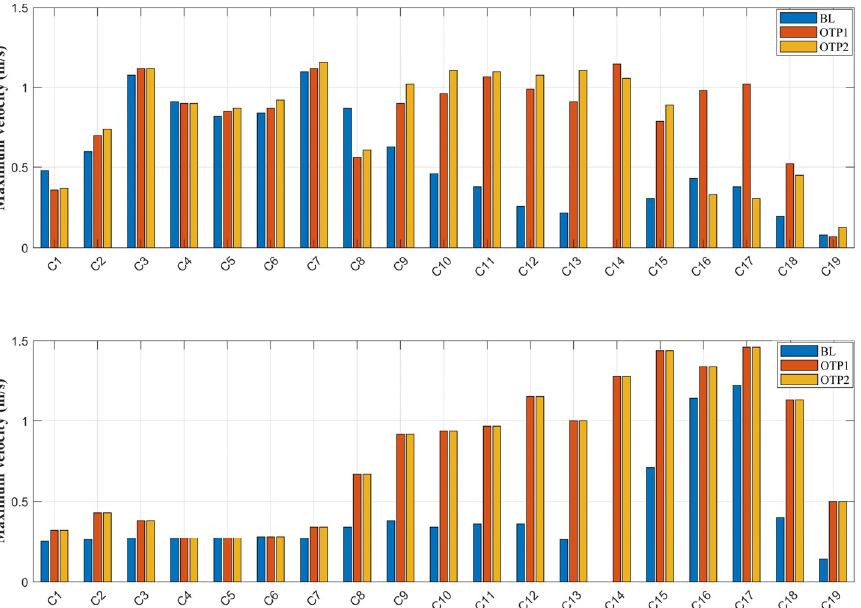
Figure 25. Maximum velocity during the Northeast monsoon ( upper panel) and flood event ( lower panel).